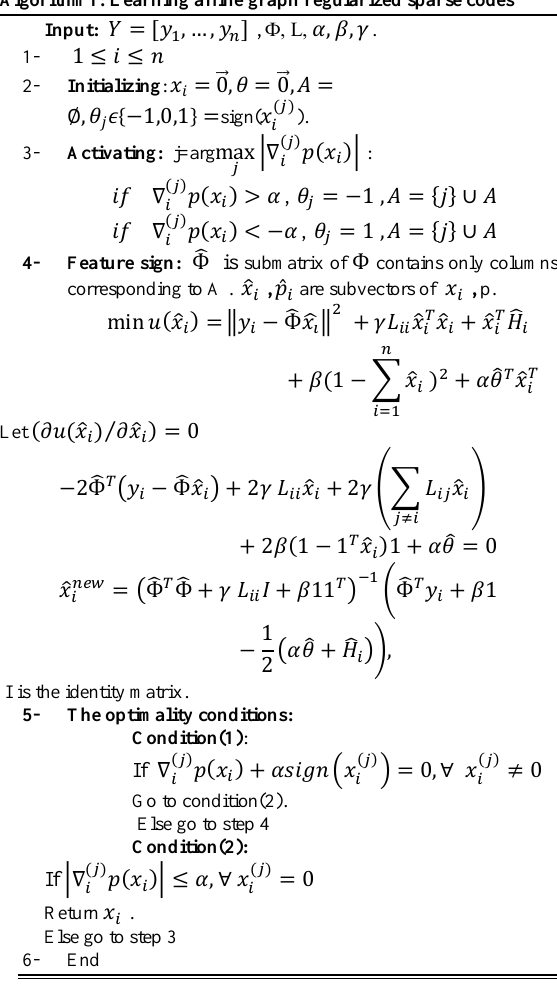
Algorithm1: Learning affine graph regularized sparse